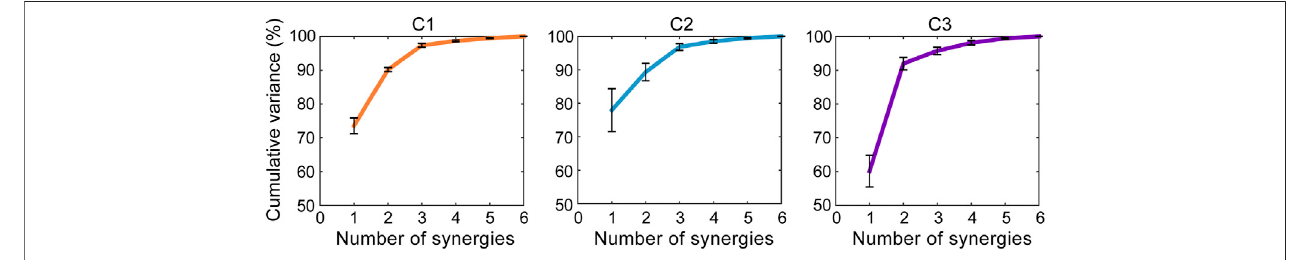
FIGURE 4 | The overall variance of all the tasks in each cluster explained by the core synergies. The core synergies of a cluster represent the common synergistic characteristicsofallthemotortasksinthecluster,andareextractedfromthedataofallthetasksbelongingtothecluster.Thelinesanderrorbarsindicatethemeansand standard deviations of the cumulative percentage of the overall movement variance explained by the synergies across the subjects ( n (cid:1) 9), respectively.